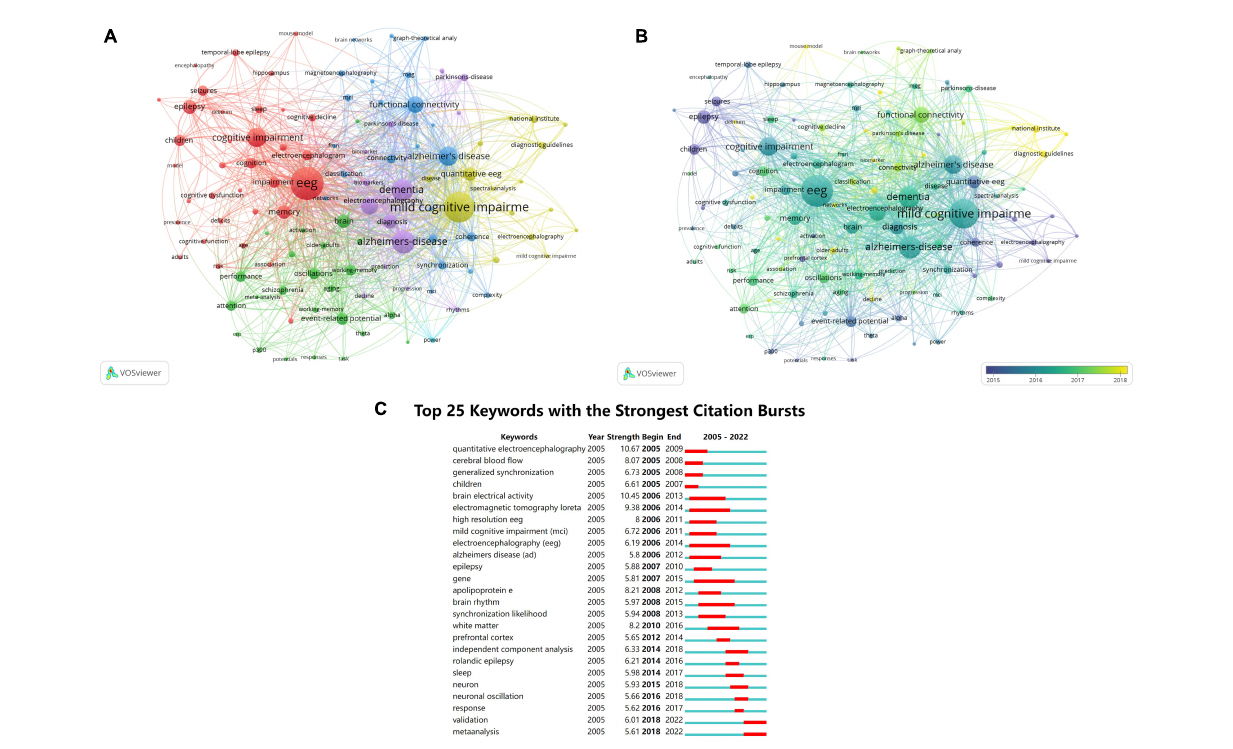
FIGURE7 (A) Network visualization of keywords based on VOSviewer. The size of the node denotes the number of occurrences of the keywords, the lines indicate that they appear together in the same document, and the color represents the various clusters. (B) Overlay visualization of keywords based on VOSviewer. The color of the keywords corresponds to the time axis below, representing their time of appearance. (C) Top 25 keywords with the strong citation bursts.